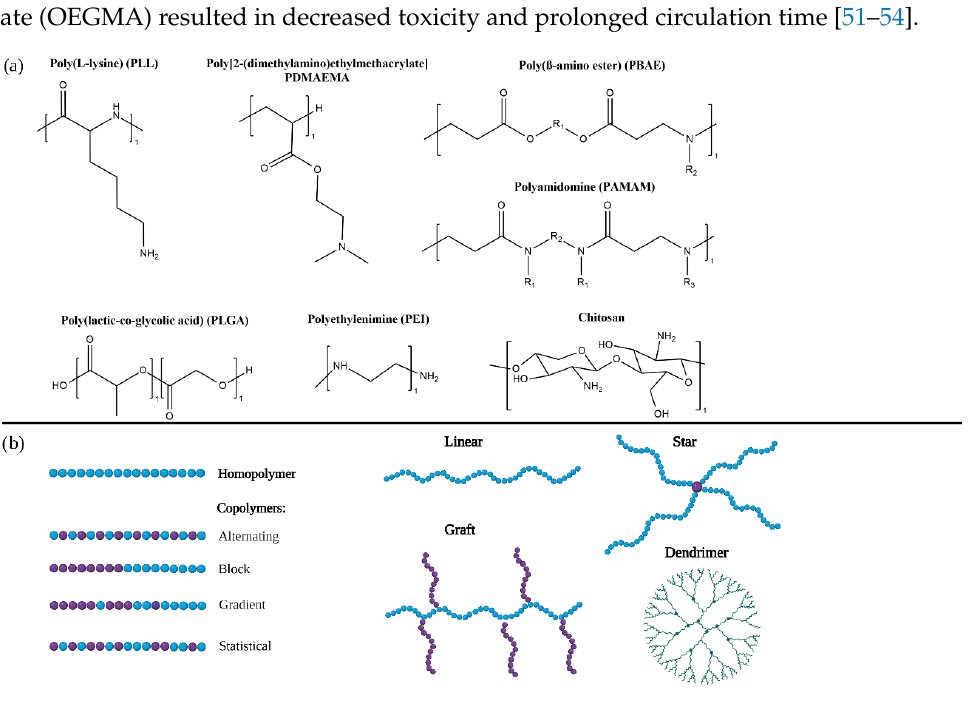
Figure 1. ( a ) Chemical structures of commonly used polymers in RNA therapeutics. ( b ) Schematical illustrations of different polymer architectures and topologies .